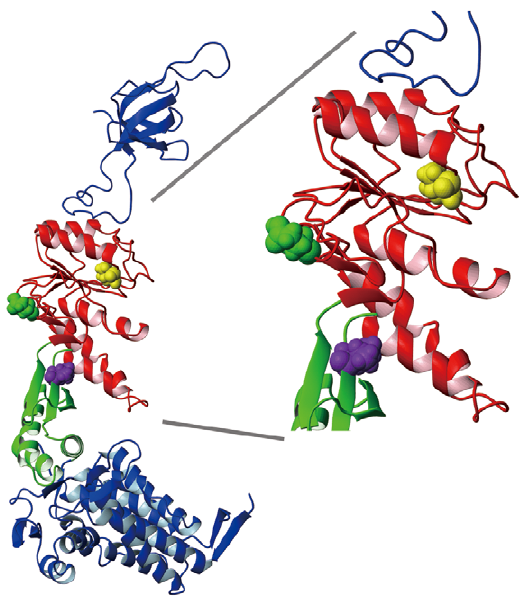
Figure 1. Locations of the N- and C-termini in the three circular permutation mutants of the present study. An X-ray structural model of a single GroEL/GroES subunit pair taken from PDB structure file 1 AON [3], depicting the three locations where the N- and C-termini were relocated in the three CP mutants. The locations are indicated by colored CPK representation of the first (N-terminal end) amino acid of each CP mutant, excepting the starting methionine and any extraneous amino acids that were added as a consequence of the experimental protocol (see Materials and Methods). The green molecule denotes Glu 209, the yellow molecule Val 254, and the magenta molecule Val 376 in wild type GroEL.